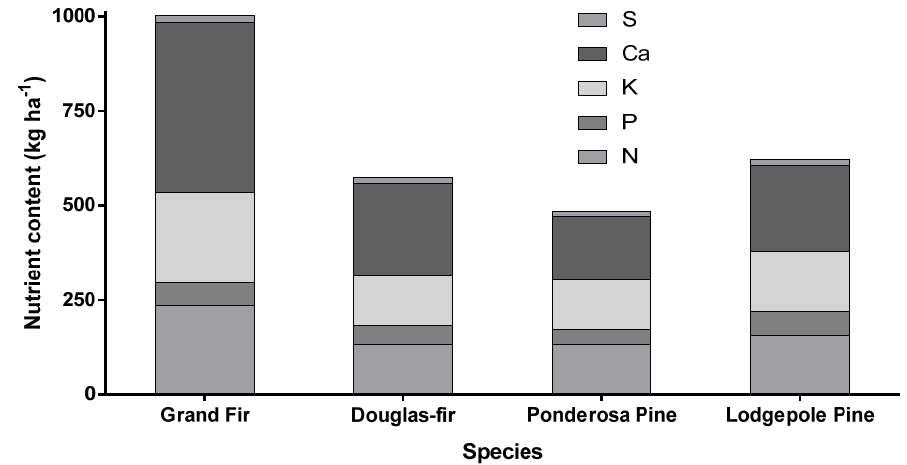
Figure 2. Relative cumulative frequency graphs of foliar N ( a ), K ( b ), and Ca ( c ) concentrations for grand fir (GF), inland Douglas ‐ fir (DF), lodgepole pine (LP), and ponderosa pine (PP). Y ‐ axis shows the proportion of trees sampled that are below the nutrient concentration on the horizontal axis.